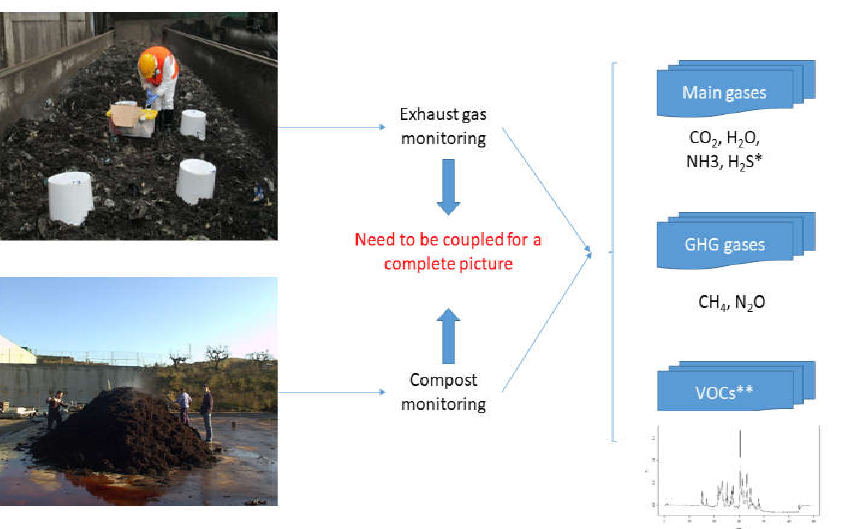
Figure 1. Monitoring exhaust gases from a composting process. * H 2 S is only significantly observed when anaerobic con- served when anaerobic conditions prevail in the composting process. ** VOCs: Volatile Organic ditions prevail in the composting process. ** VOCs: Volatile Organic Compounds, a wide group including families such Compounds, a wide group including families such as alcohols, aldehydes, alkanes, aromatic hydro- as alcohols, aldehydes, alkanes, aromatic hydrocarbons, carboxylic acids, ketones, nitrogen compounds, phenols, sulphur carbons, carboxylic acids, ketones, nitrogen compounds, phenols, sulphur compounds, and terpenes, compounds, and terpenes, among others. among